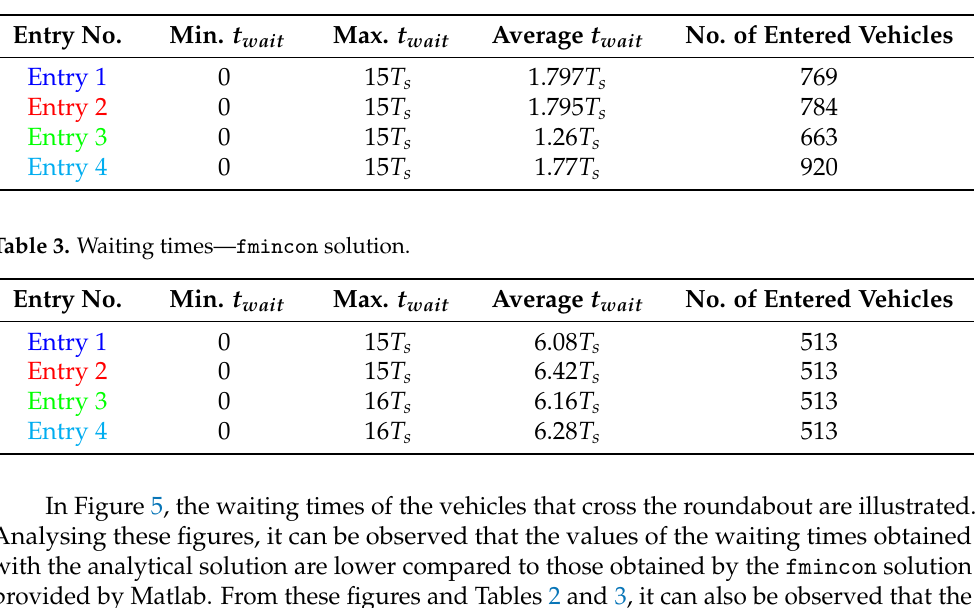
Table 2. Waiting times—analytical solution.